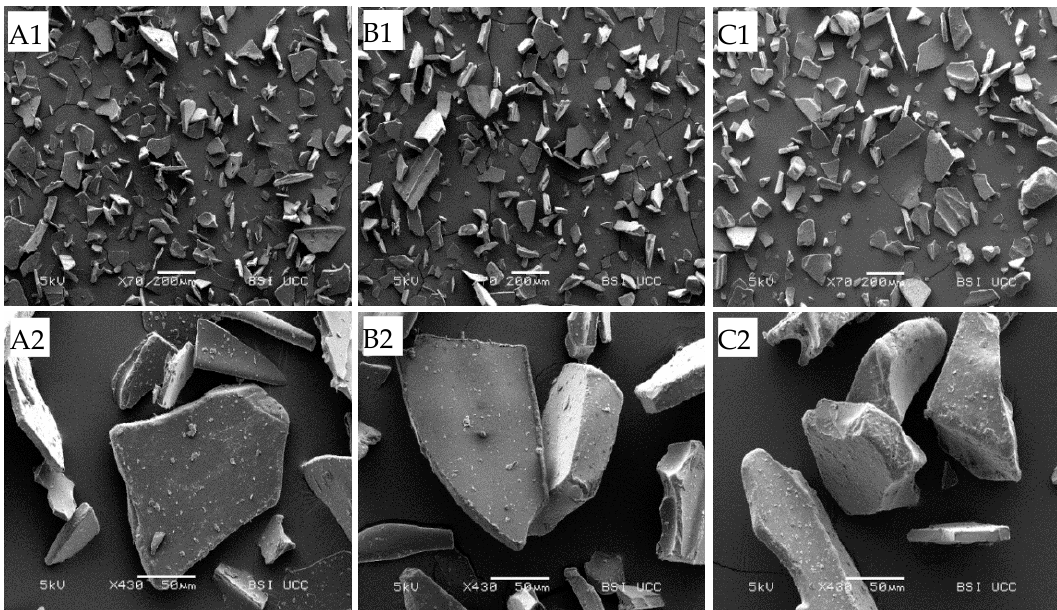
Figure 1. Scanning electron microscopy images ( A1 – C1 , 70 × , and A2 – C2 , 430 × ) of freeze-dried MCC powder: ( A ) (P-MCC-0G), ( B ) (P-MCC-10G), and ( C ) (P-MCC-20G) prepared from MCC solutions containing 0, 10, and 20% GMP as a percentage of total protein, respectively.